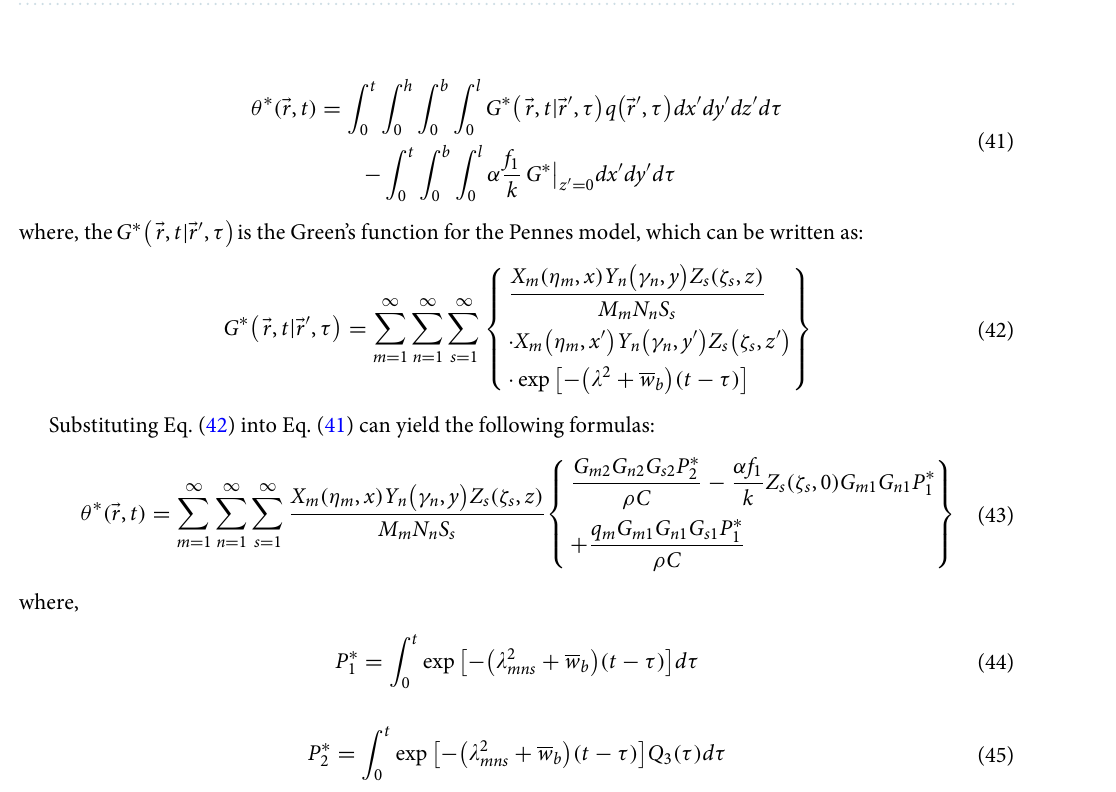
Figure 4. The FEM model of the skin (created by Abaqus 6.14, https:// www. 3ds. com/ zh/ produ cts- servi ces/ simul ia/ produ cts/